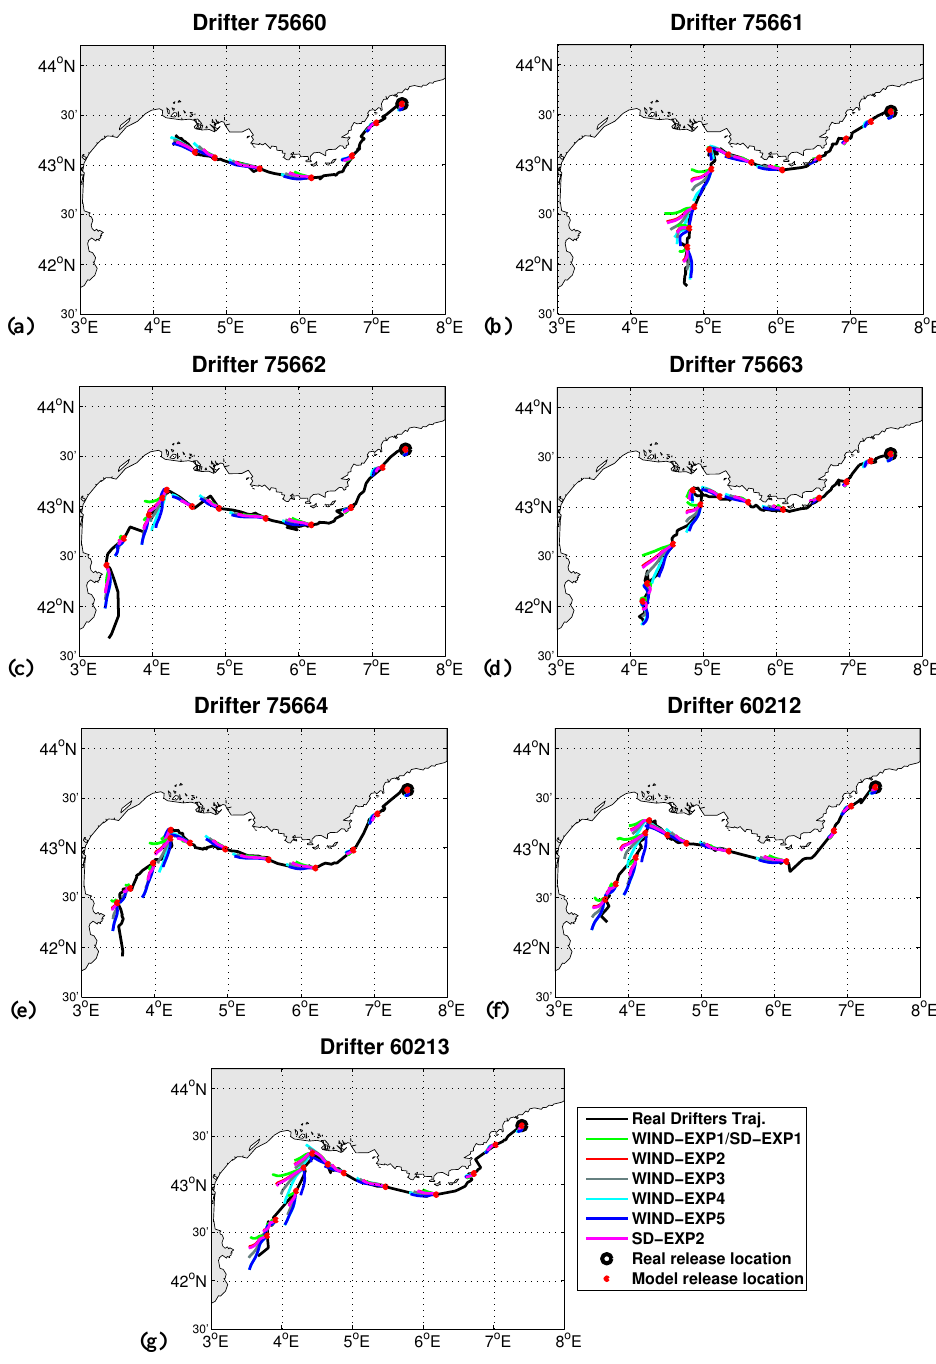
Fig. 5. As in Fig. 4, but the simulated trajectories last for 24h and are re-initialized every day, from 10 to 22 October 2007.